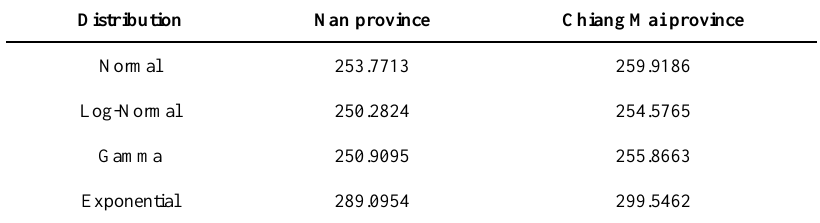
Table 6. The minimum Akaike Information Criterion (AIC) values of the Nan and Chiang Mai provinces.